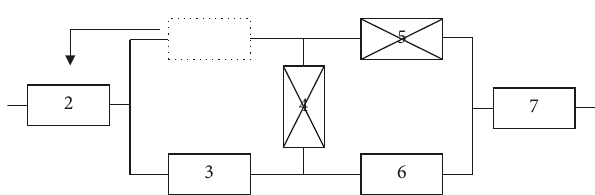
Figure 6: System structure after implementing swapping strategy 1.